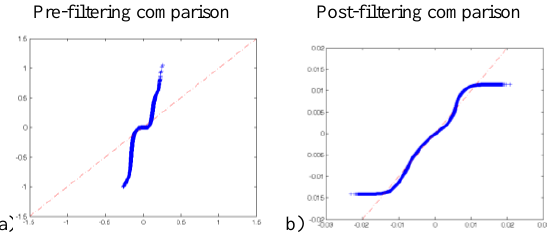
Figure 12. Q-Q plots of the comparison MMS vs. TLS for the Garibaldi dataset. The quantiles of input sample (vertical axis) are plotted against the standard normal quantiles (horizontal axis). Pre-filtering (a) and post-filtering (b) data are shown.